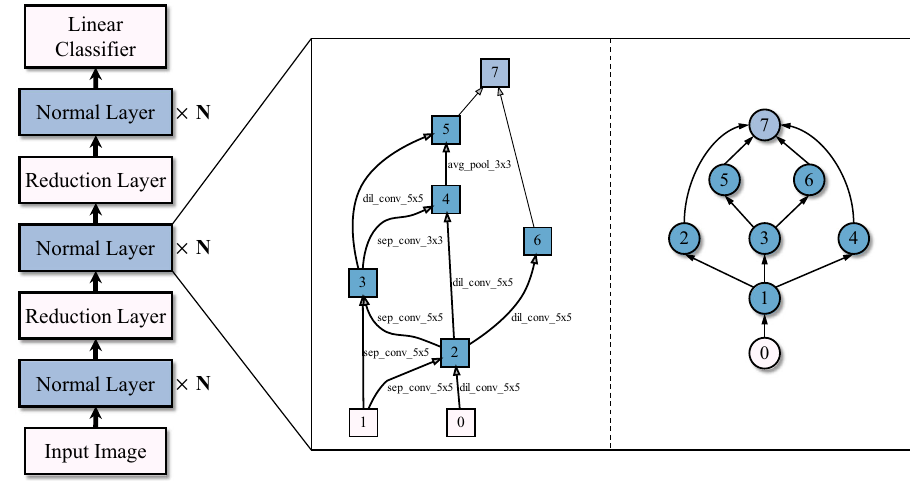
Fig. 1 The micro [55] and macro [47] search spaces adopted in our approach. Left: overall network architecture. Middle and right: design of layers in micro and macro search